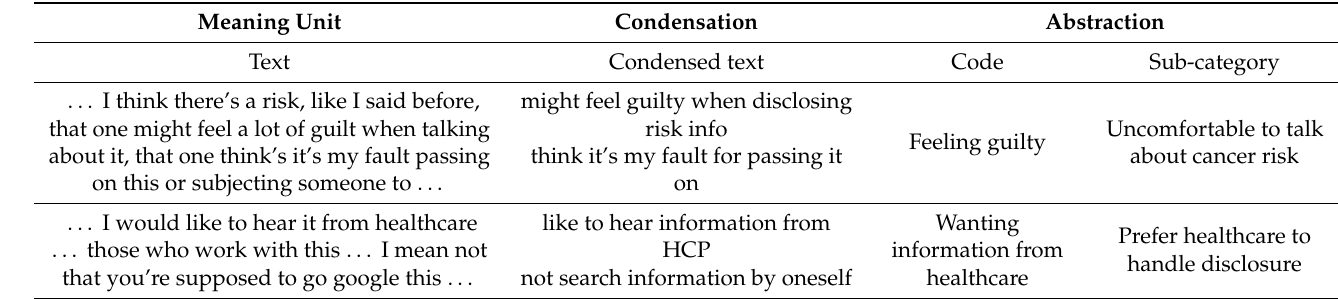
Table 1. The initial steps in qualitative content analysis illustrated with two examples of identified meaning units. Meaning Unit